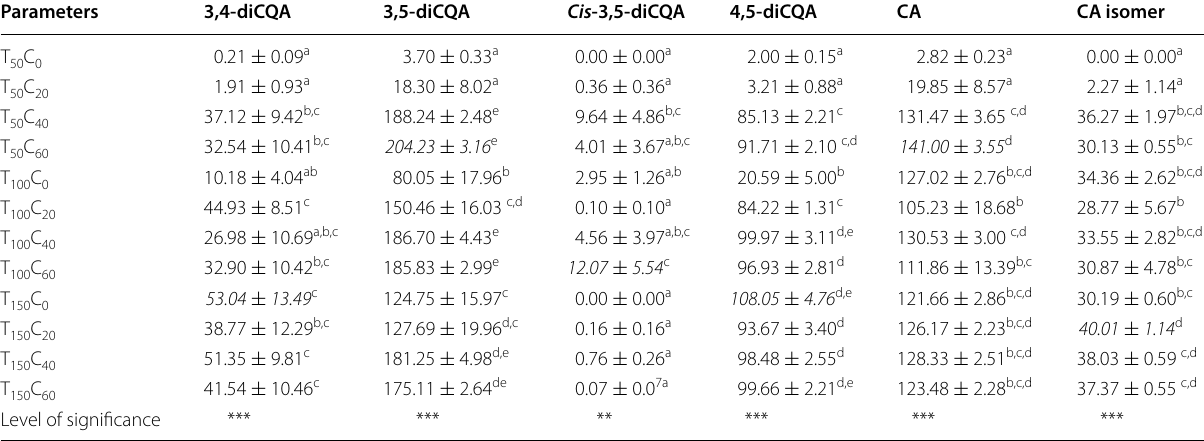
Table 2 Yield (mean relative peak intensity) of identified anti HIV analogues extracted from B. pilosa using modified PHWE